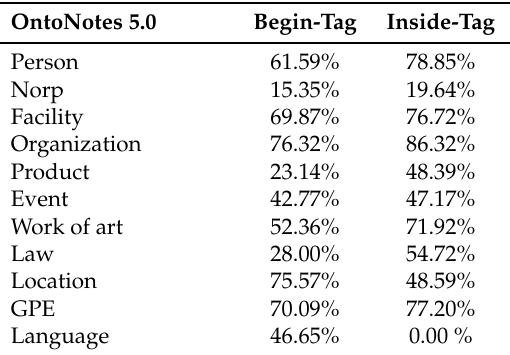
Table 7. The coverage of the dictionary on the OntoNotes5.0 dataset.